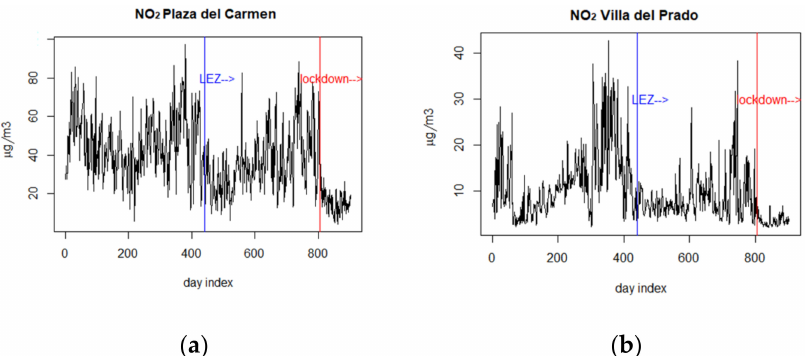
Figure 3. Daily average NO 2 levels between 1 January 2018 and 20 June 2020. ( a ) displays NO 2 levels at Plaza del Carmen air monitoring station, located in Madrid city center. ( b ) displays NO 2 levels at Villa del Prado air monitoring station, located in a rural area.